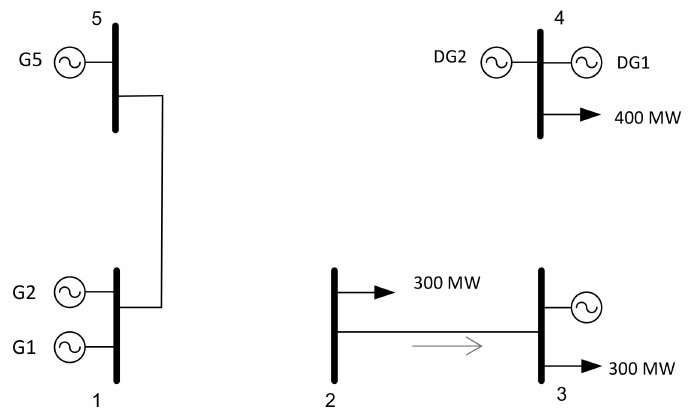
Figure 6. Topology of the system after the worst